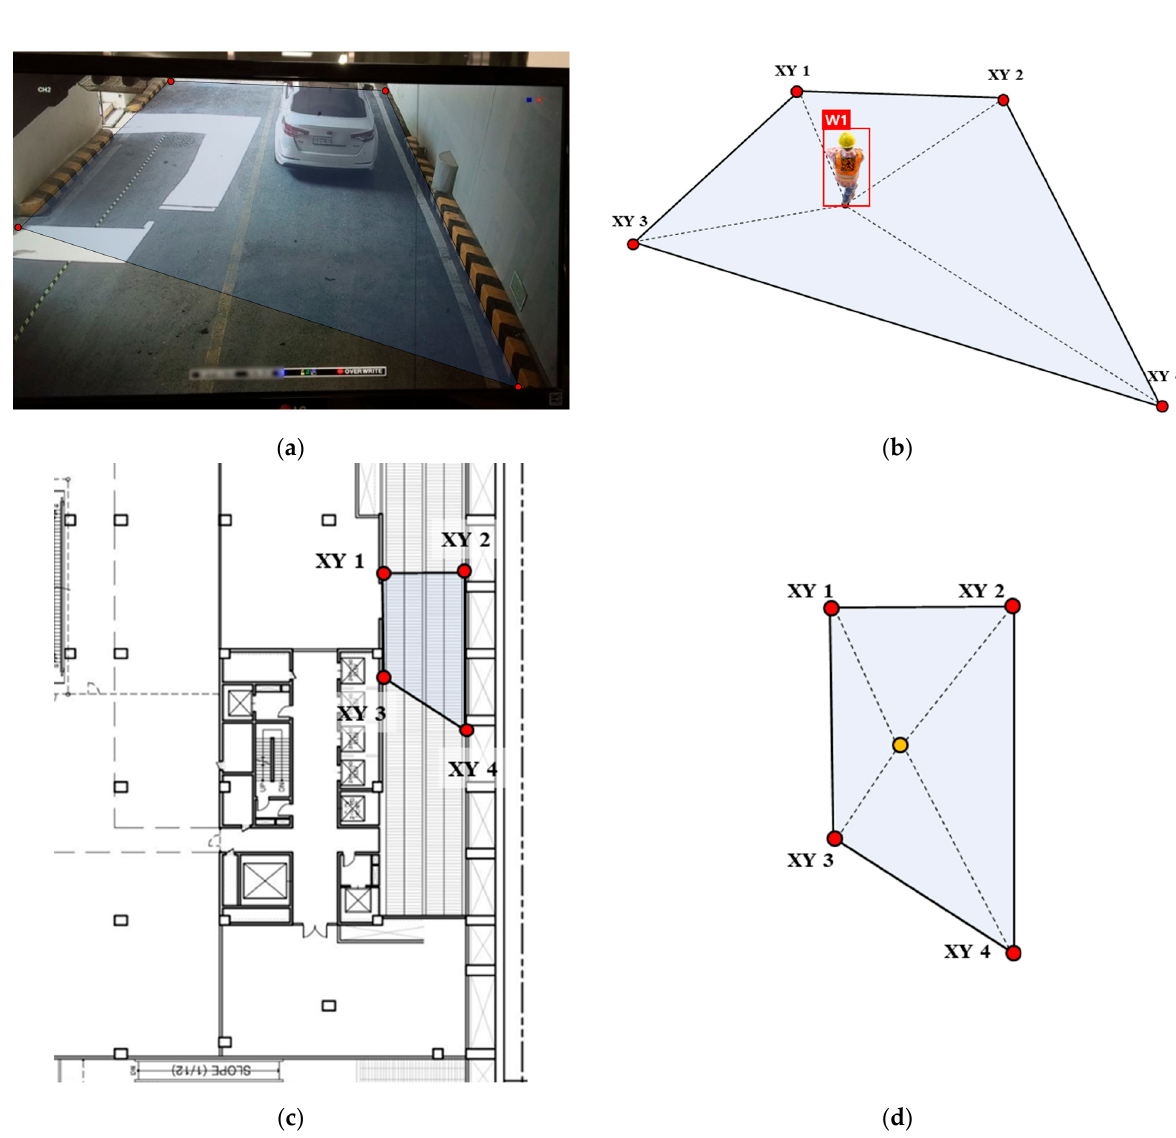
Figure 5. Conception of matching process between image and drawing: ( a ) setting 4 points to be used as the location standard from the on-site CCTV video; ( b ) estimating the relative position of the recognized object from the polygon created by the set 4 points; ( c ) setting the positions corresponding to the 4 points in the drawing and calculating the polygon’s distortion rate.; ( d ) estimating the position on the drawing of an object recognized by CCTV using the calculated results.